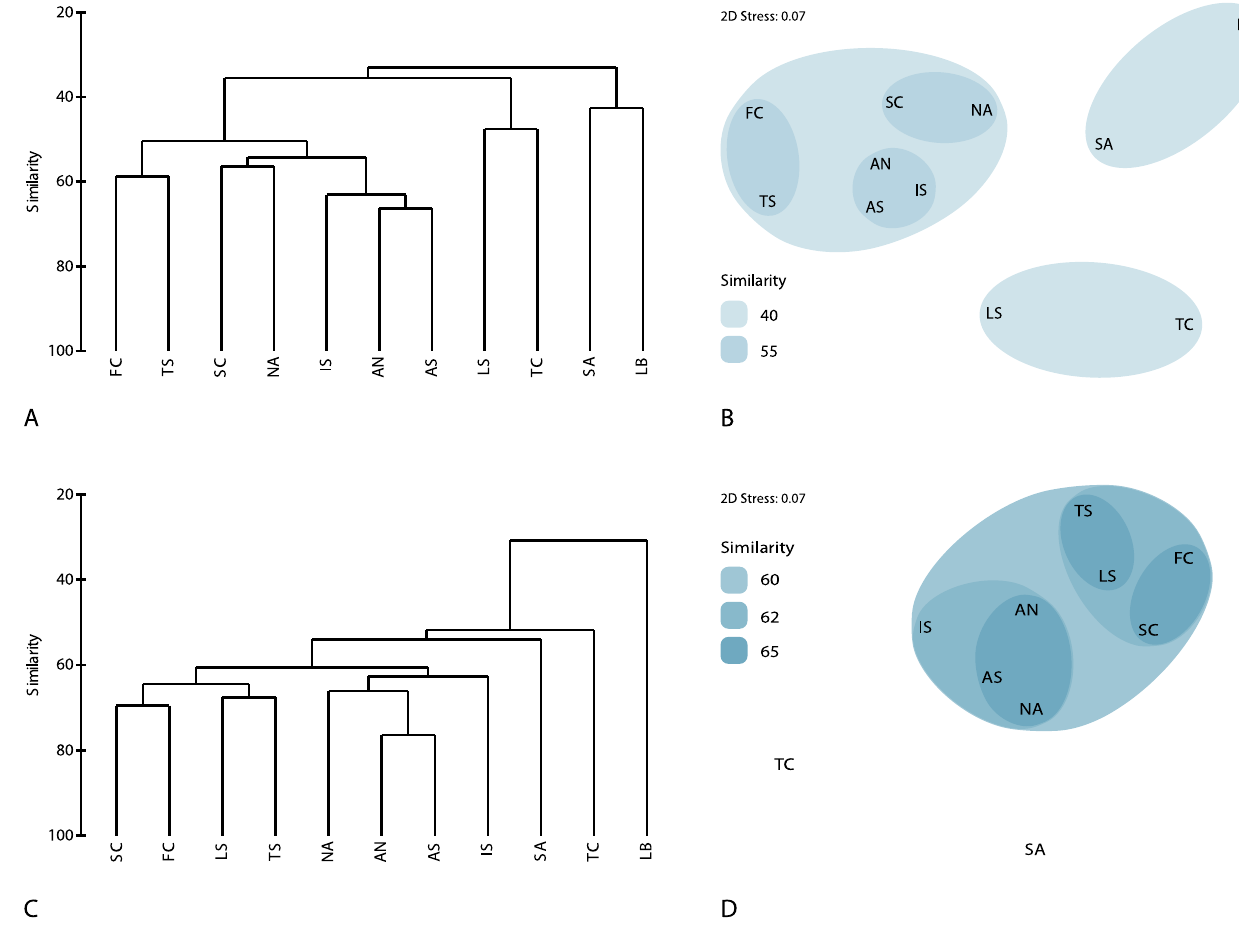
Figure 7. Resemblance of sponge assemblages in the Mediterranean subareas demonstrated in dendrograms and non-metric MDS plots. (A, B) cave assemblages, (C, D) overall Mediterranean assemblages. In the latter analysis, data for the Levantine Basin were omitted (see Methods). For abbreviations of Mediterranean areas see Methods.